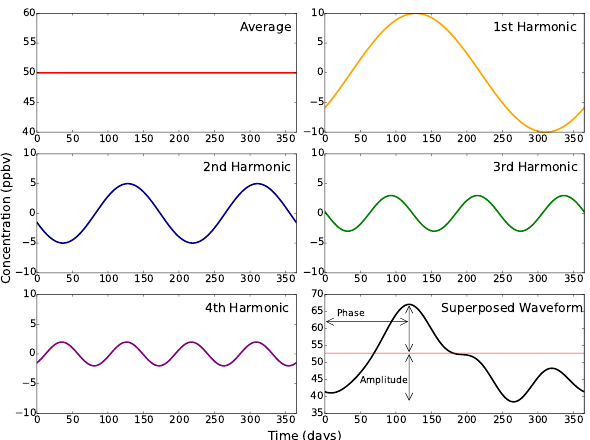
Figure 3. Example of spectral superposition of the average, funda- mental frequency and the harmonics for a frequency of